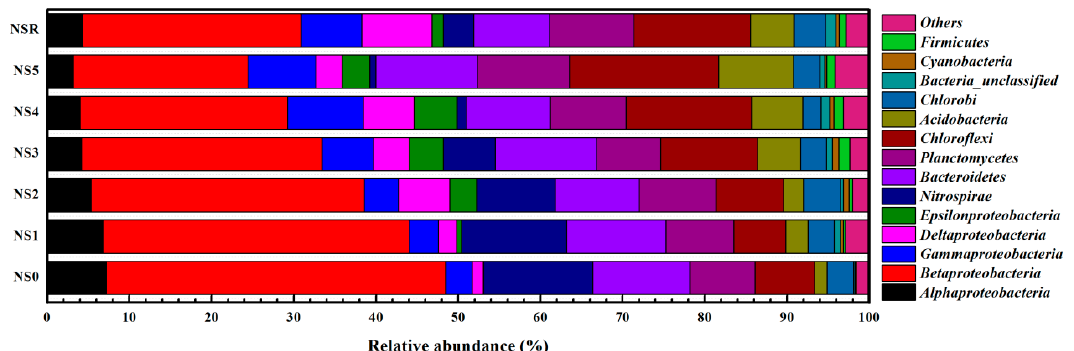
Figure 5. The relative abundances of different classes of Proteobacteria and phyla (>1% in any sample) in sludge samples (NS0, NS1, NS2, NS3, NS4, NS5, and NSR).